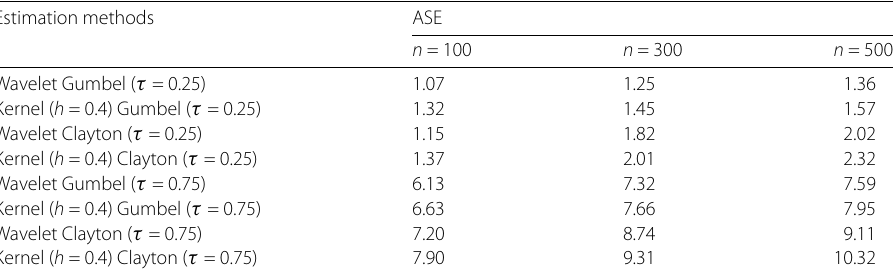
Table 1 Computed value for ASE compared between the proposed wavelet estimator in our paper and kernel estimator (defined in lopez(2015)) based on two copulas for various sample sizes Estimation methods ASE n = 100 n = 300 n = 500 Wavelet Gumbel ( τ =